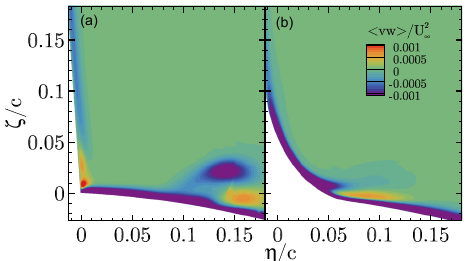
Figure 31. Reynolds shear stress (cid:104) vw (cid:105) of the chord-wise and span- wise velocity at x c /c = 0 . 5. CaseT1.0 (a) , CaseT1.0-fairing (b) .